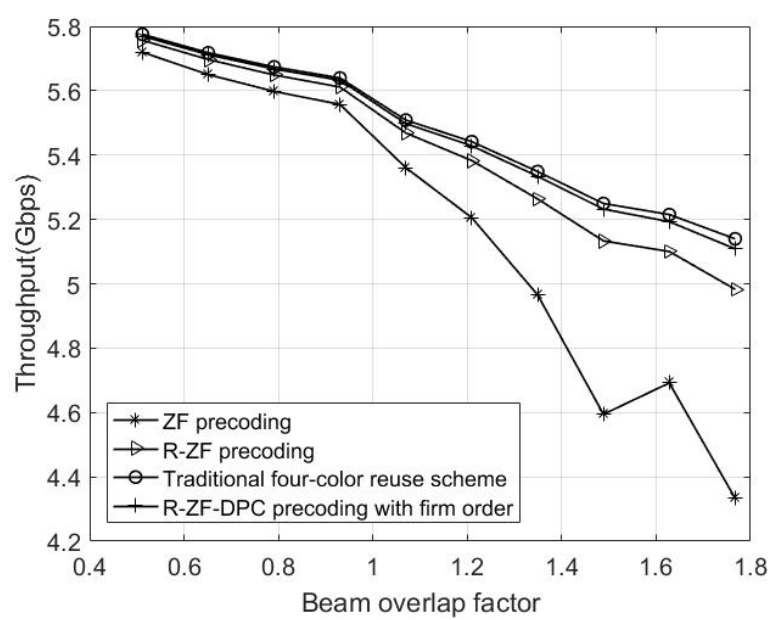
Figure 8. Influence of overlap factor on throughput performance of precoding schemes with random user location.